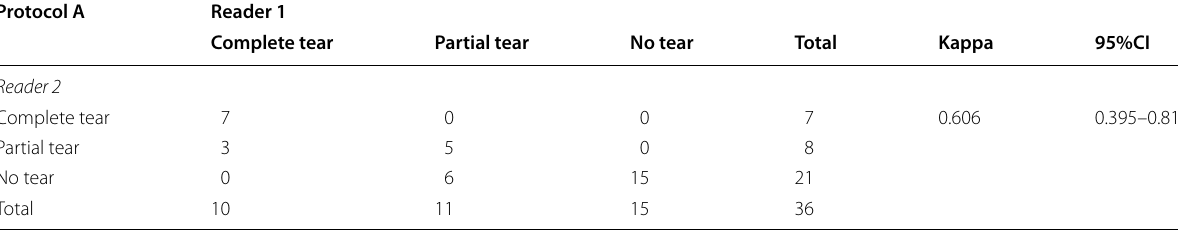
Table 7 Interobserver agreement between the two readers in imaging with protocol A Protocol A